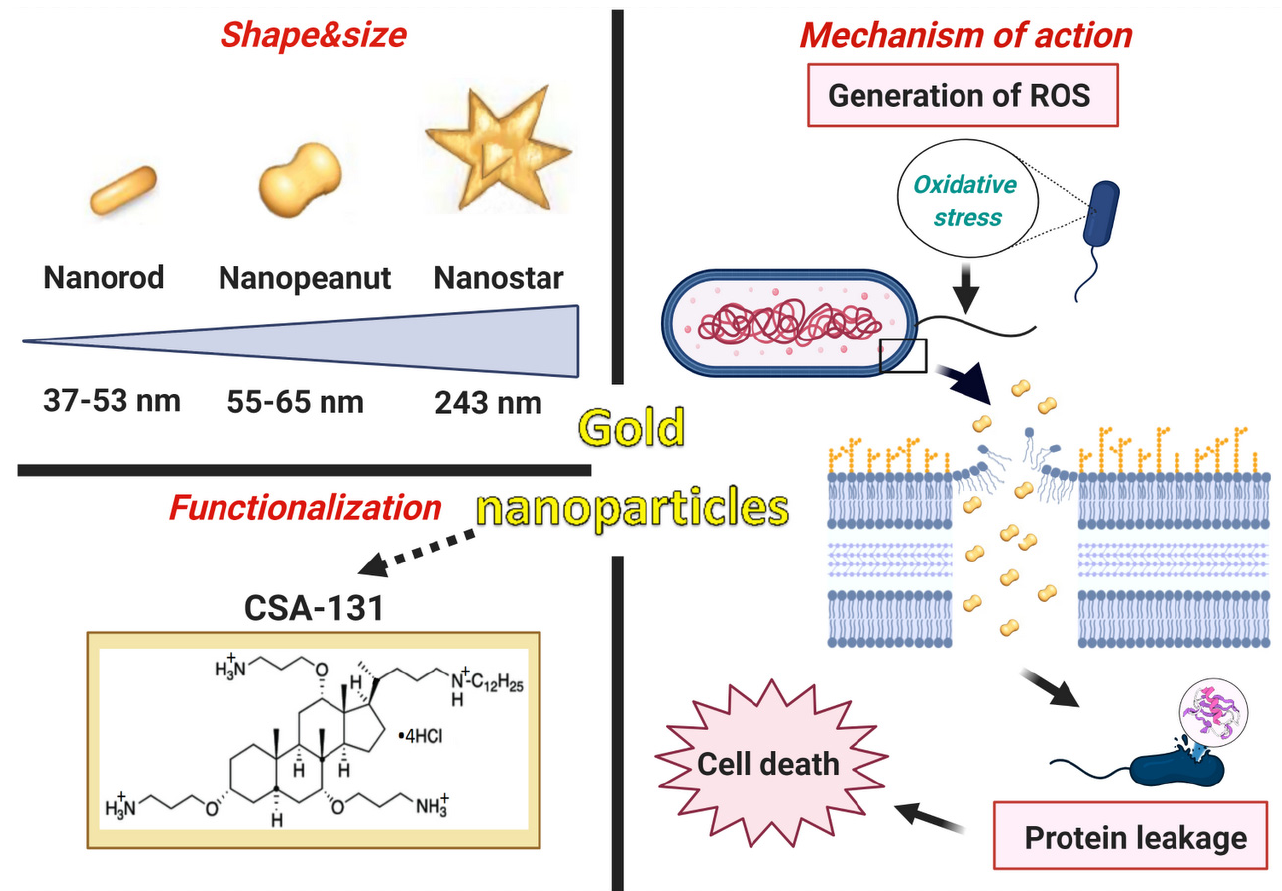
Figure 9. Characteristics of gold nanoparticles functionalized by CSA-131. Proposed antimicrobial mechanism of the developed nanosystems which comprises the generation of ROS (reactive oxygen species) associated with the destruction of the bacterial membranes as well as the leakage of the intracellular content and consequently cell death. The figure was prepared using BioRender.